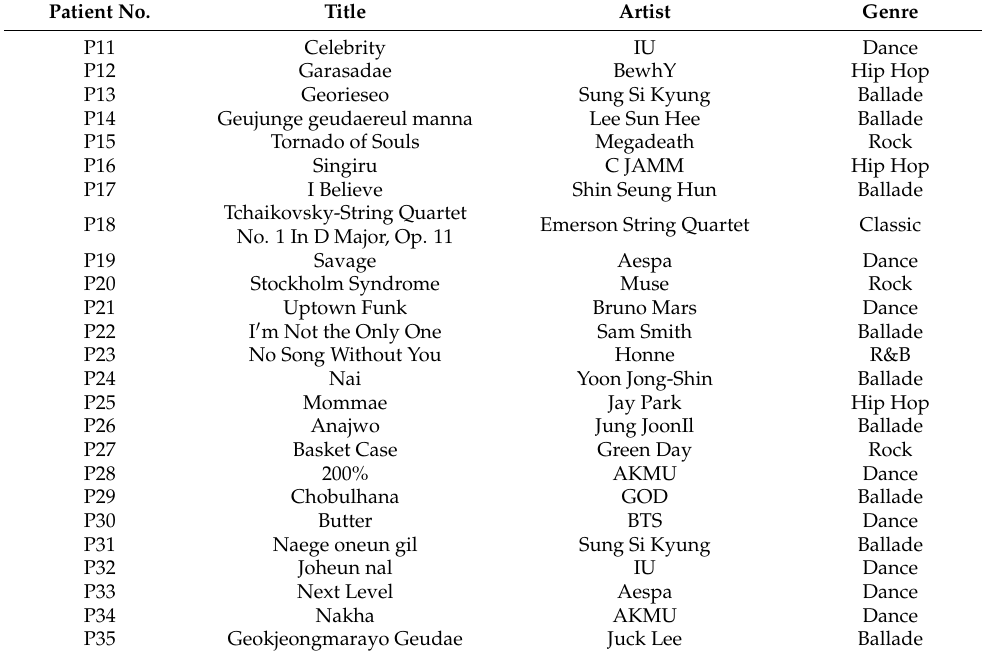
Table A1. Cont. Patient